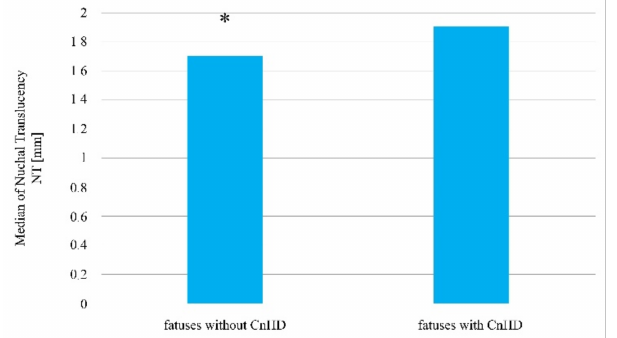
Figure 5. The median nuchal translucency thickness value amongst fetuses with and without a diagnosed congenital non-heart defect amongst patients who became pregnant without the use of assisted reproduction techniques. * Statistically significant difference (Mann–Whitney U test; p < 0.05).